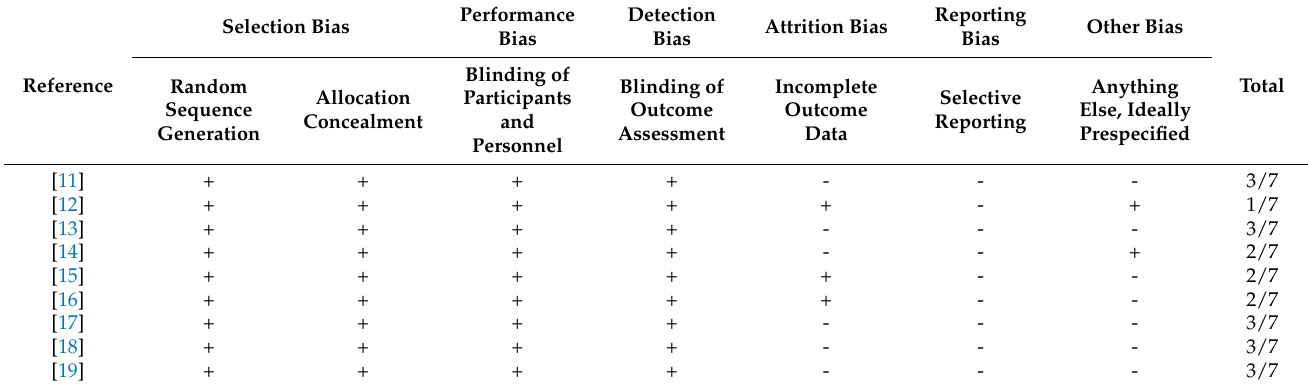
Table 4. Cochrane Risk of Bias Assessment Tool for Randomized Clinical